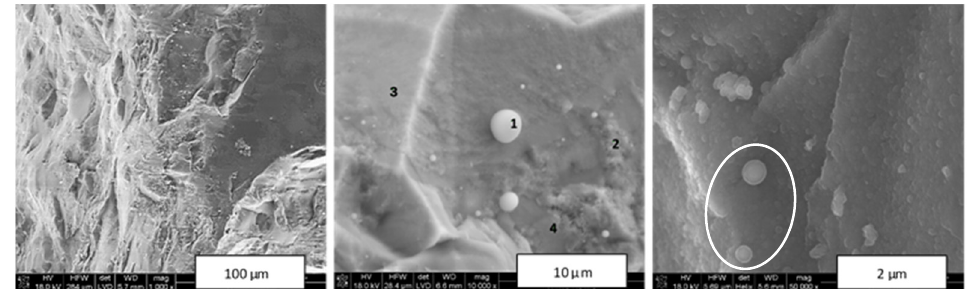
Figure 5. SEM images of intentionally fractured nanoceramics of Composite_800_sint_1200. Numbers in the middle image show spots subjected to EDX analysis (see, text). In the right image, apparently partially molten shell–core spheres are encircled by white ellipses.